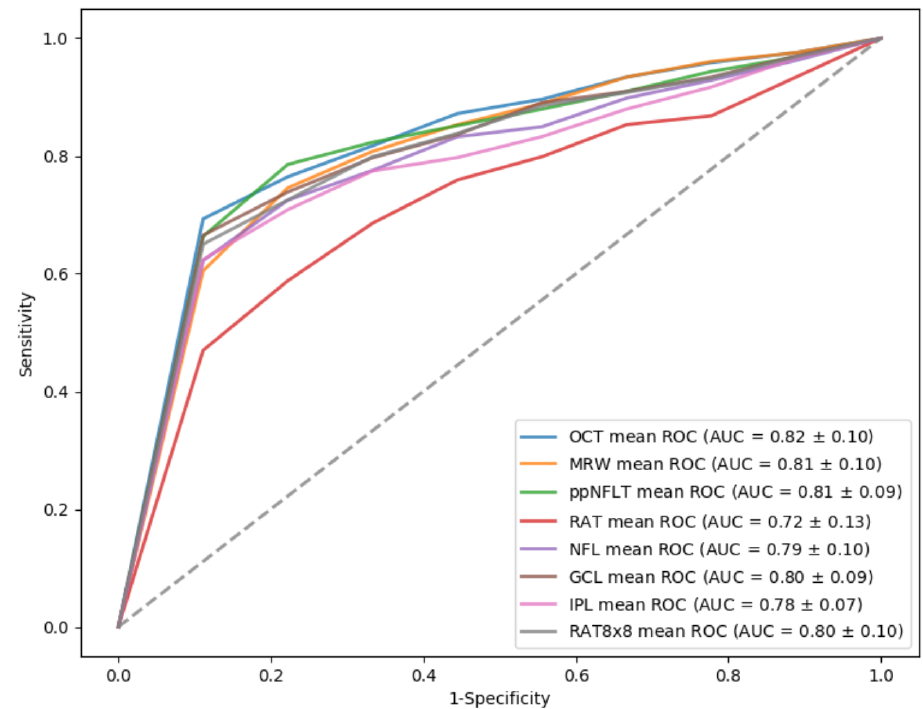
Figure 2. Receiver operating characteristic (ROC) curve of optical coherence tomography (OCT)- related features groups in differentiating normal from glaucomatous eyes.